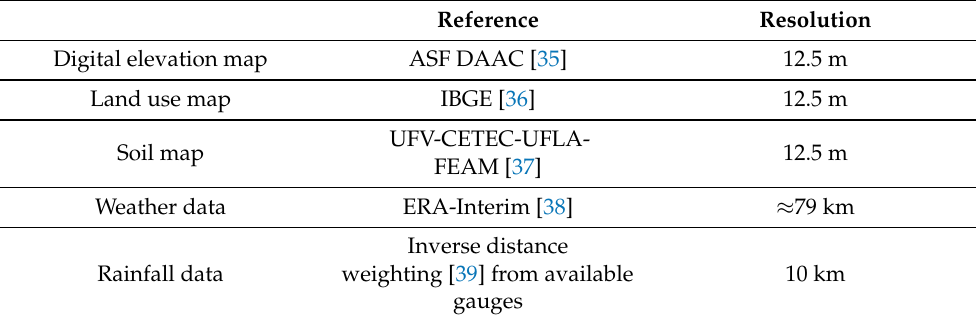
Table 1. Description of maps and data used in the setup of boundary conditions. Reference Resolution Digital elevation map ASF DAAC [35] 12.5 m Land use map IBGE [36] 12.5 m UFV-CETEC-UFLA- 12.5 m Soil map FEAM [37] Weather data ERA-Interim